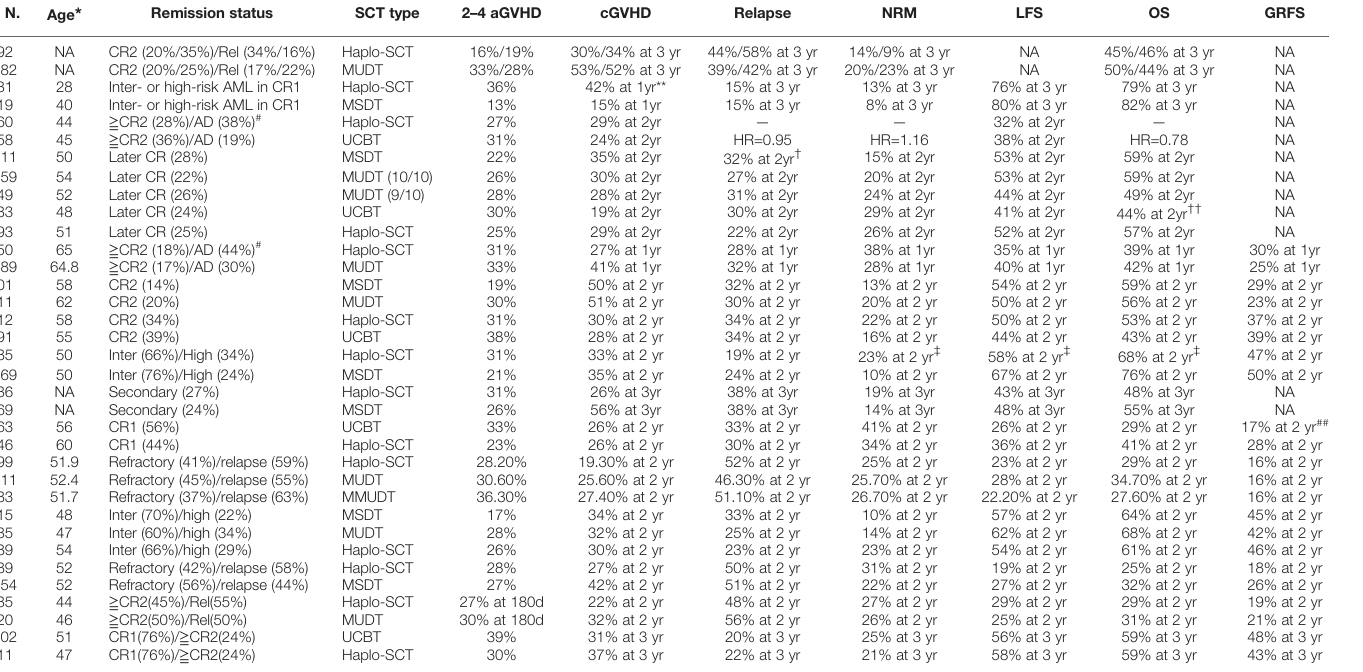
TABLE 1 | Recent studies comparing the outcomes of AML patients between haplo-SCT and other transplantation modalities. Authors Ciurea SO, et al.